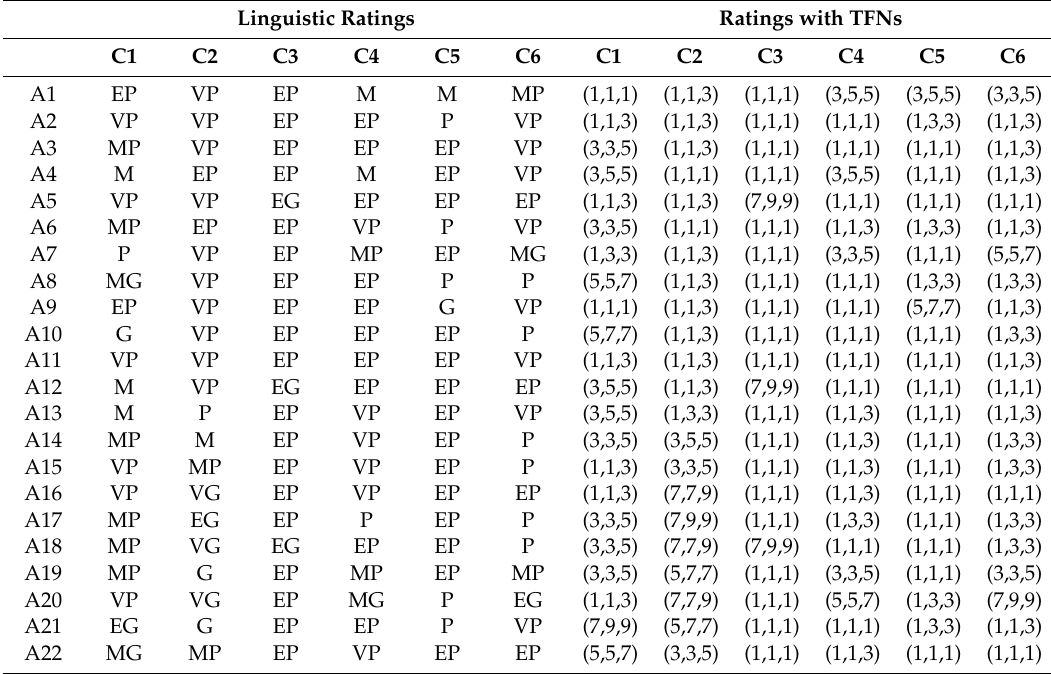
Table 2. Extended initial fuzzy decision